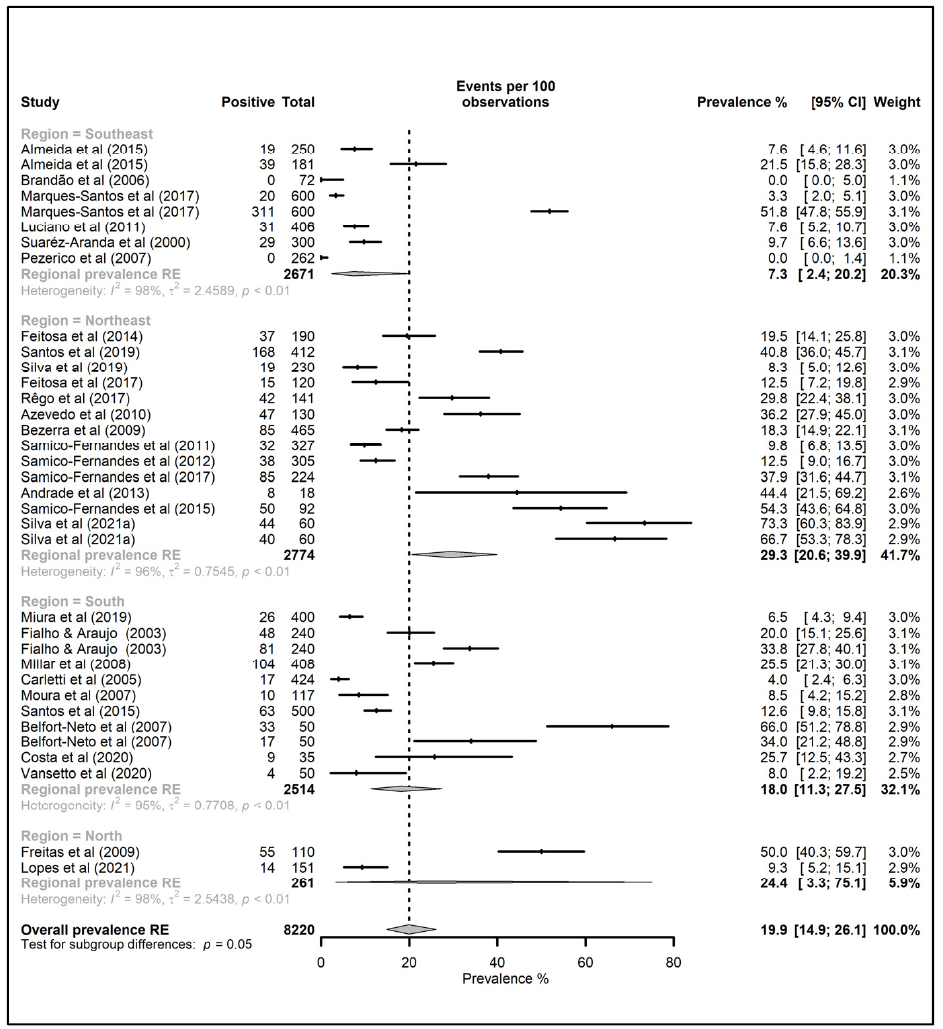
Figure 3. Forest tree of studies reporting toxoplasmosis prevalence in pigs in Brazil, grouped by admin- istrative region (North, Northeast, Southeast and South). CI: confidence interval; RE: random